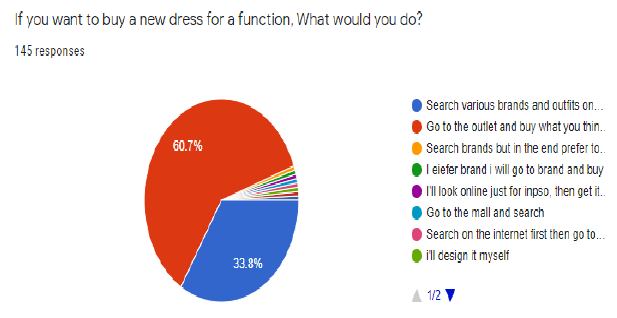
Figure 5. Respondents